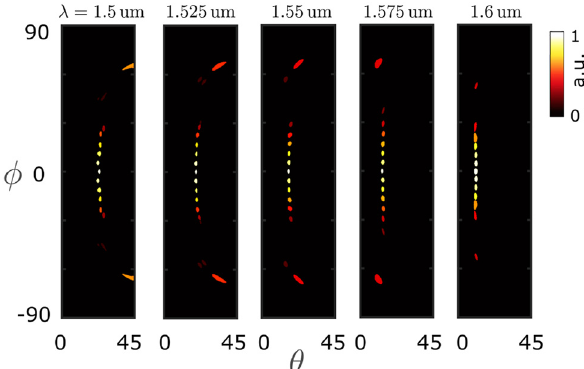
Figure 5: The radiated far-field beam profile of 15-waveguide array at 5 different wavelengths, demonstrating the potential for polar angle beam scanning through wavelength tuning. In each panel all beam intensities are normalized to the peak intensity of the central